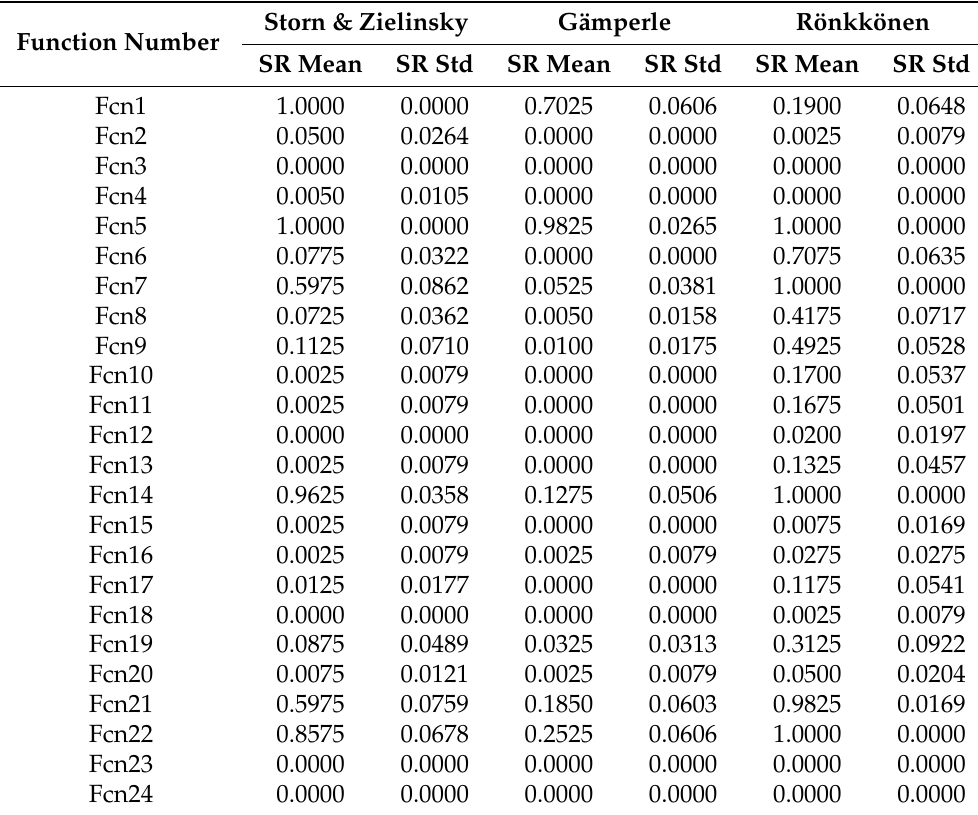
Table 8. Experimental results by DE algorithm for 24 BBOB objective functions following four distinct parameter tuning rules: Storn and Price, Gämperle et al., Rönkkönen et al. and Zielinsky et al. From Storn and Price rule, and Zielinsky et al. rule, a combination called Storn & Zielinsky is designed that meets both rules. The mean (SR mean) and standard deviation (SR std) values of SR are calculated over 10 DE algorithm independent